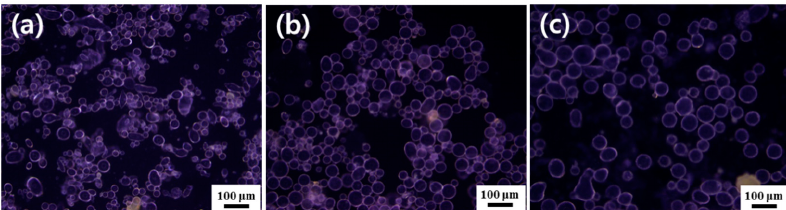
Figure 7. Fluorescence micrographs of oil-in-water Pickering emulsions of three different oils stabilized by PMDA-ODA particles (0.5 wt %): ( a ) linseed oil, ( b ) olive oil, and ( c ) phenyl acetate. Fluorescence micrographs are provided for more clarity (excitation wavelength = 330~380 nm).